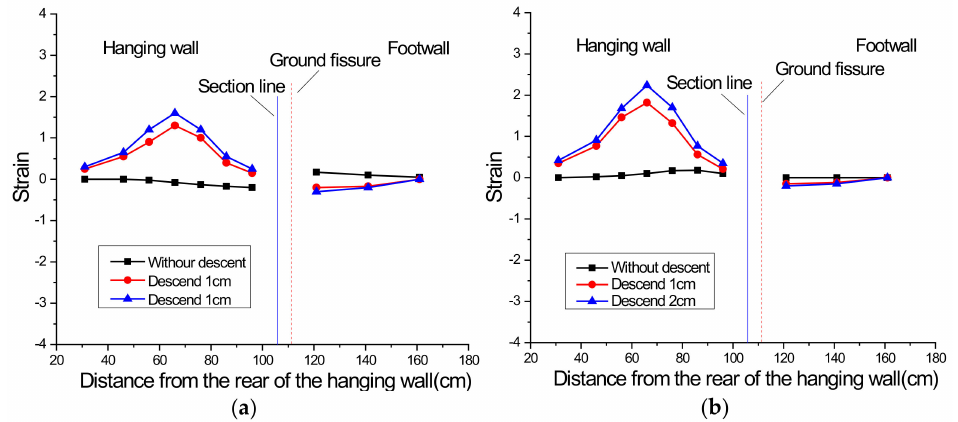
Figure 24. Distribution of the maximum longitudinal additional strain at the tunnel bottom: ( a ) vi- bration exciter at 60 cm; ( b ) vibration exciter at 100